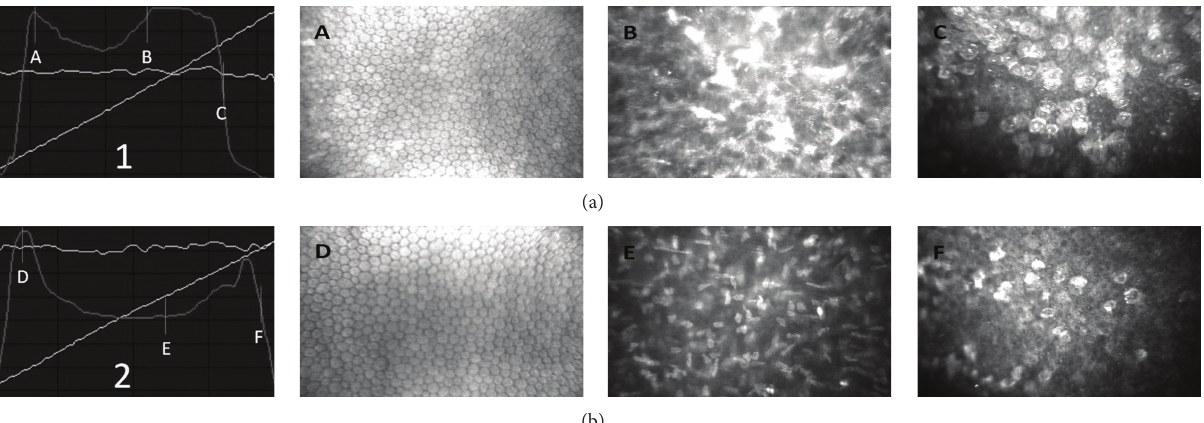
Figure 2: In vivo confocal microscopy images obtained with the scanning slit confocal microscopy 1 month after accelerated cross-linking (a) and normal cornea (b); (1): backscatter light intensity depth graph of cross-linked cornea; A: endothelium, B: demarcation line, C: epithelium, distance between B and C: depth of the demarcation line, (2): backscatter light intensity depth graph of normal cornea, D: endothelium, E: midstroma, and F: